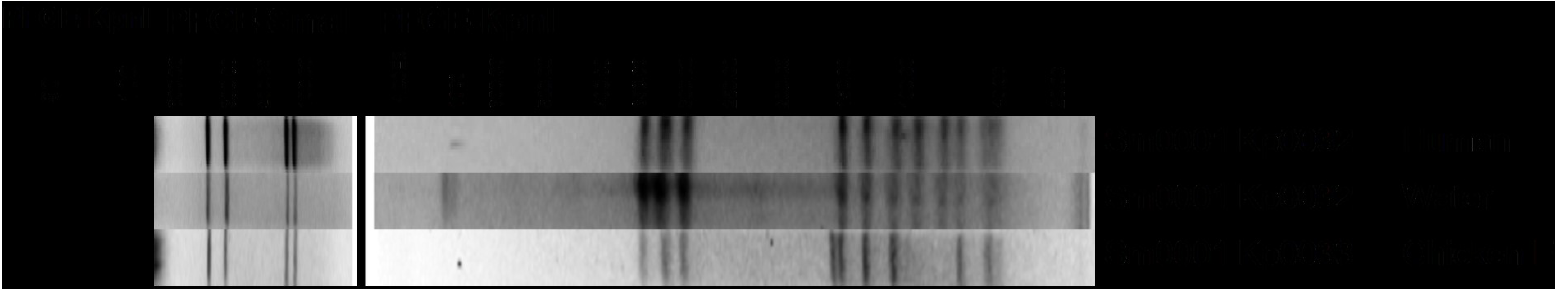
Figure 3. Clonal relationships between Campylobacter jejuni human and environmental isolates and subtype Sm0001/Kp0032 from chicken